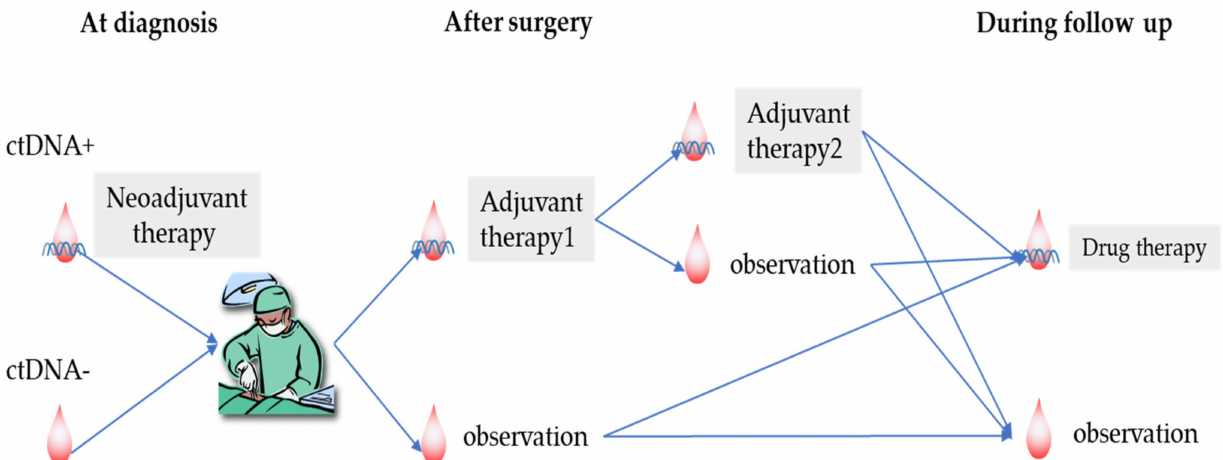
Figure 3. ctDNA-guided perioperative management in the future. This figure demonstrates a future perioperative treatment strategy for patients with resectable NSCLC according to the minimal residual disease assessment. The treatment strategy for neoadjuvant and adjuvant therapies will be determined based on the status of circulating tumour DNA (ctDNA) at diagnosis, after surgery, and during the surveillance